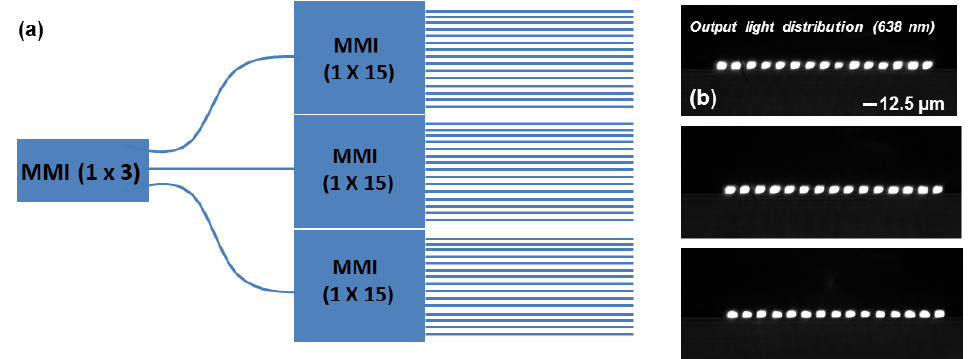
Figure 12. A 1 × 45 MMI coupler. ( a ) Overview of the MMI. ( b ) Output light distribution under excitation at 638 nm.